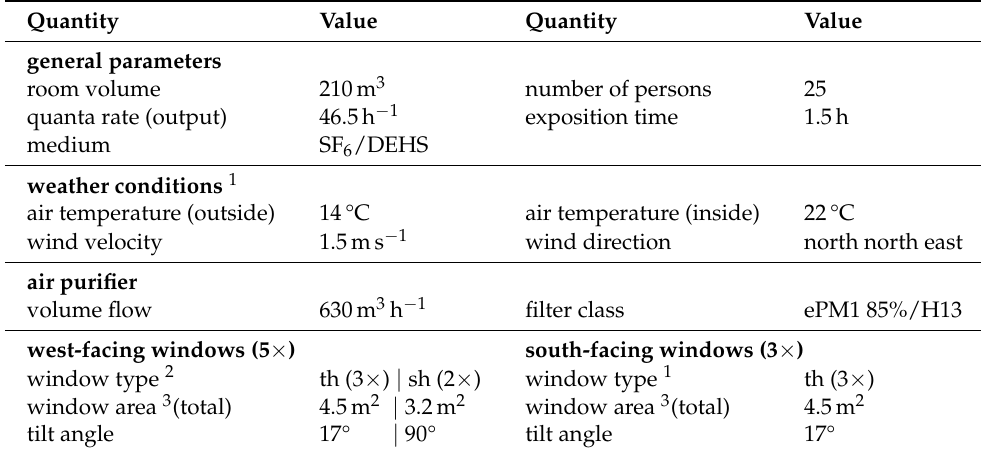
Table 4. Boundary conditions of the experiments in the